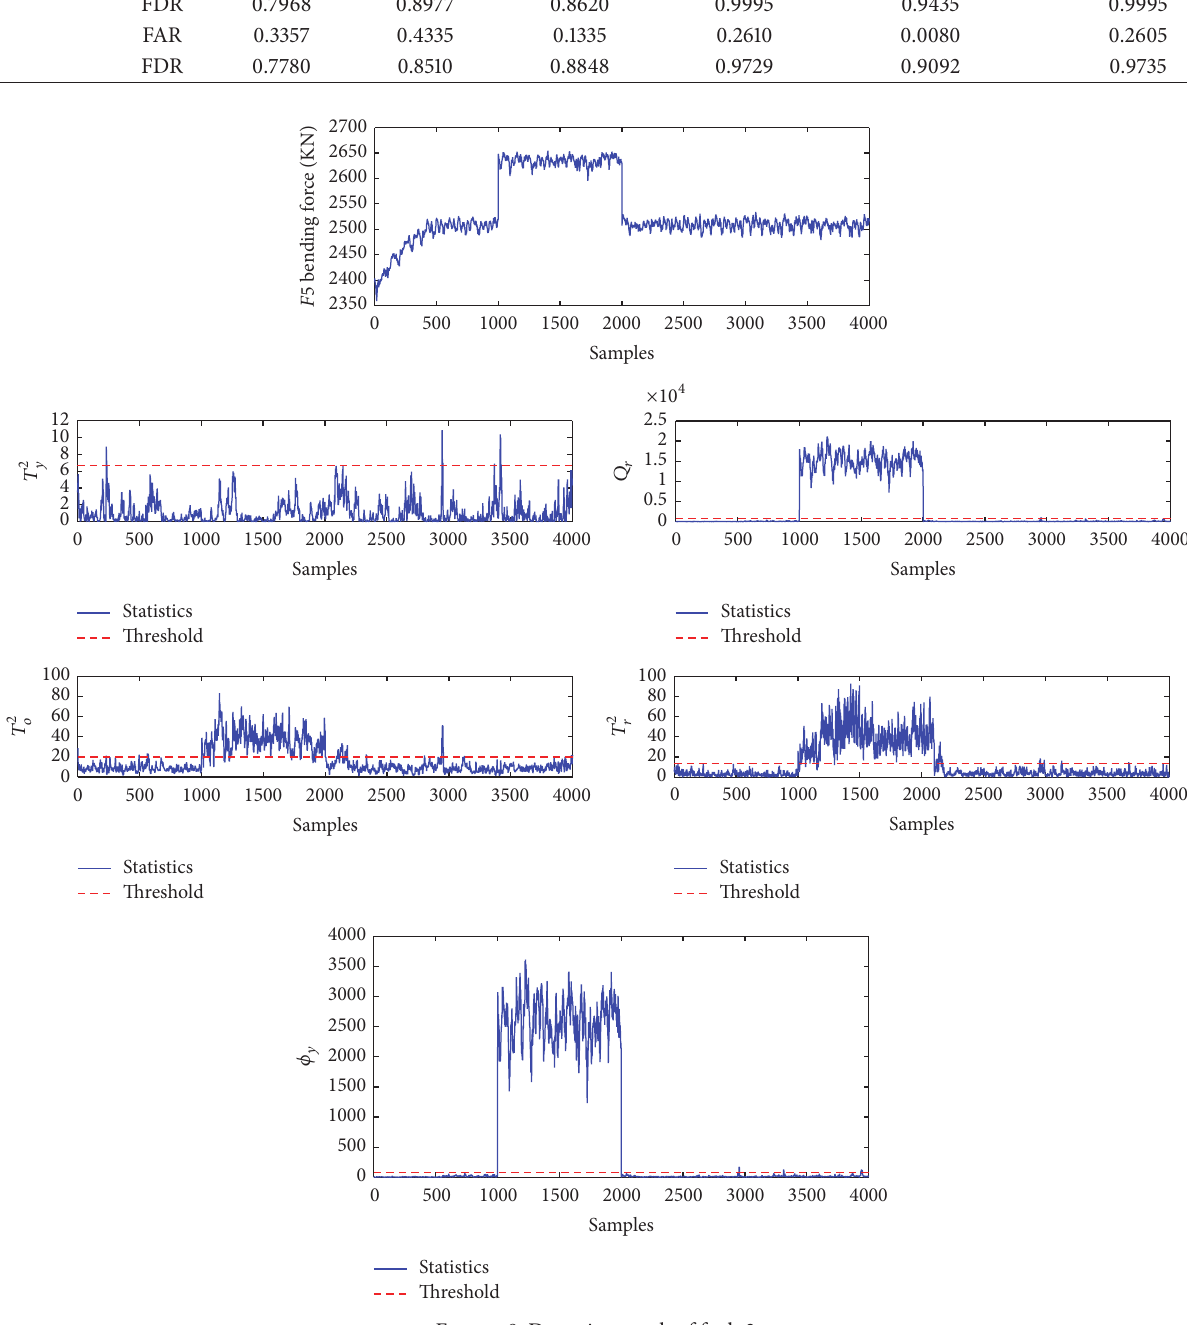
Figure 8: Detection result of fault